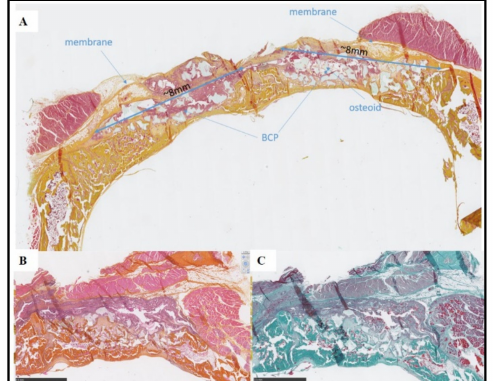
Figure 10. Histological views at 2 weeks. ( A ) Overall view of the calvaria with the two defects filled by BCP granules and Si-HPMC membrane on the left and DexMA membrane on the right. ( B , C ) Higher magnification of the defect implanted with BCP granules and covered with the IPN membrane, with HES ( B ) and Goldner ( C ) staining. After 2 weeks, there were no signs of excessive inflammation in the soft tissue, ( B ) the defects were filled by the BCP granules, and osteoid tissue can be seen around the granules ( C ). The IPN membrane can be clearly identified up to the bone graft material ( B , C ).